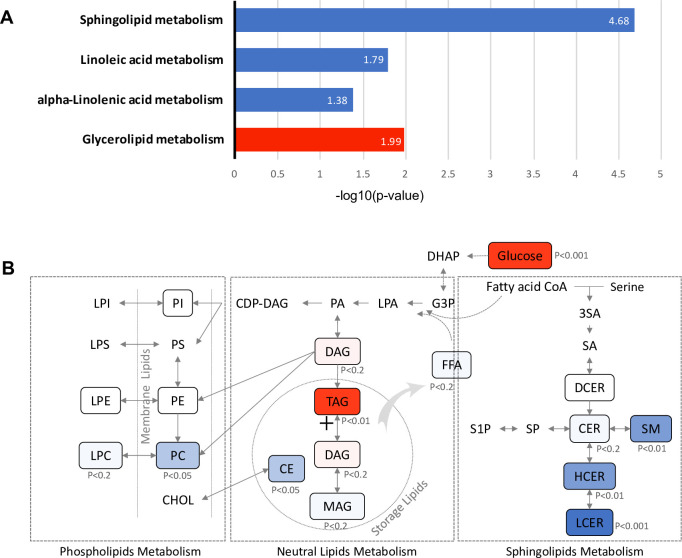
Pathways associated with future T2D at baseline.(A) Significantly regulated biological pathways associated with future diabetes onset analyzed by Kyoto Encyclopedia of Genes and Genomes (KEGG). Blue denotes the down-regulated pathways and red denotes the up-regulated pathway. (B) The altered lipid classes in an integrated lipid metabolism pathway. Red denotes positive association whereas blue denotes negative association with significance of p-value indicated.